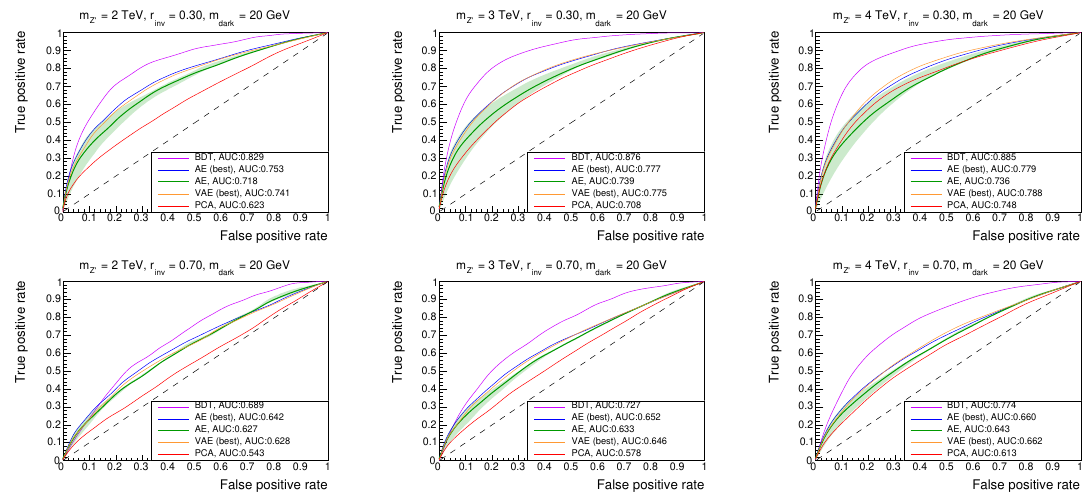
Figure 5. Comparison of the ROC curves for the autoencoder (mean and best models), PCA, BDT and VAE (the best model out of 15 trained) for a few selected